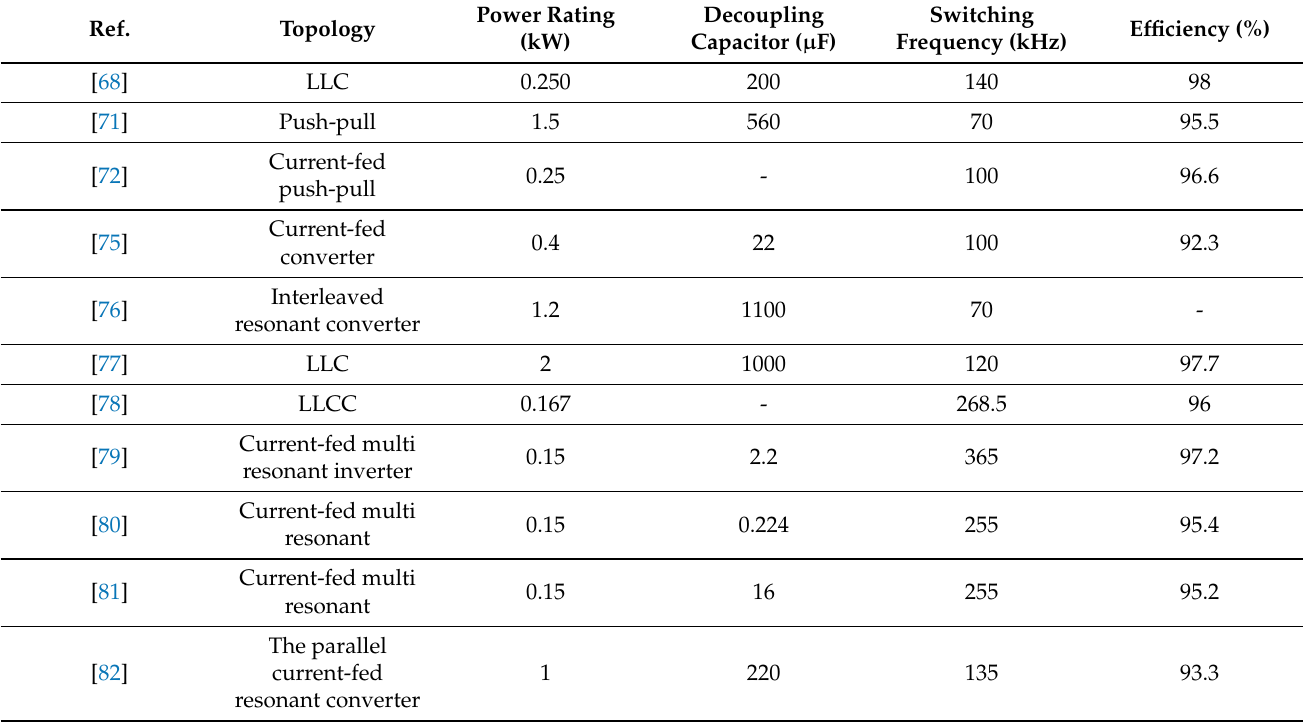
Table 4. Characteristics of DC-DC resonant power converters.